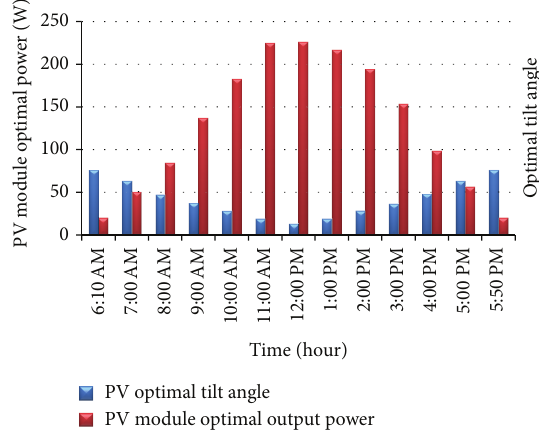
Figure 13: The optimal power and the corresponding tilt angle for June 10,